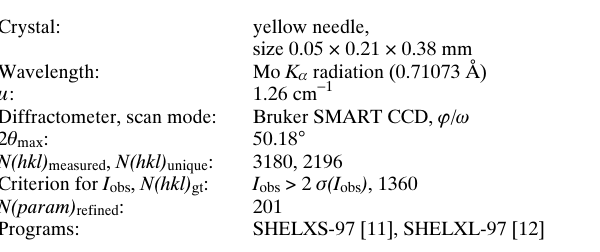
Table 1. Datacollection and